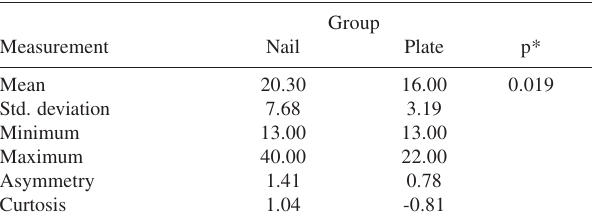
Table 6 - Results of comparison between groups Table 7 - Descriptive measurements of patients’ healing time per group Measurement